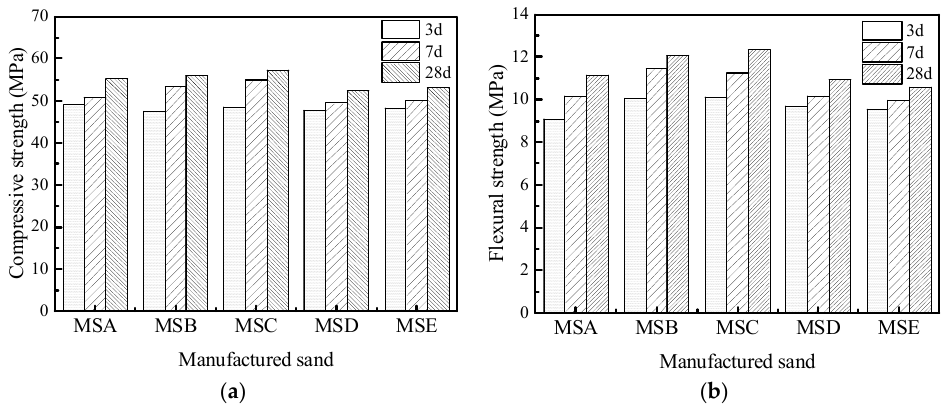
Figure 19. Mechanical properties of concrete under MF2 mix proportion: ( a ) compressive strength and ( b ) flexural strength.